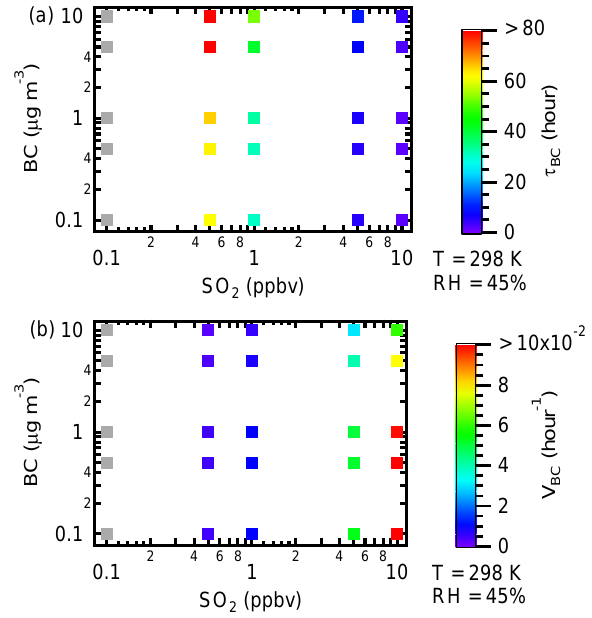
Fig. 6. Variations of (a) τ BC and (b) corresponding V BC as functions of both the initial SO 2 concentration and BC mass concentration for a given initial NO x mixing ratio of 1.0ppbv and NH 3 mixing ratio of 1.0ppbv for the lognormal BC size distribution with a D m of 175nm and σ of 1.5 for T of 298K and RH of 45% at noontime. Note that τ BC values greater than 120h are indicated in